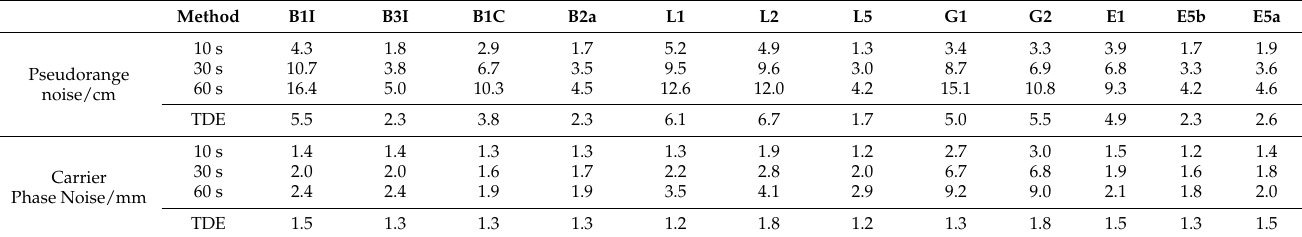
Table 4. Pseudorange and carrier-phase noise at HARB calculated by different methods. The second column is the fitting duration for the polynomial fitting